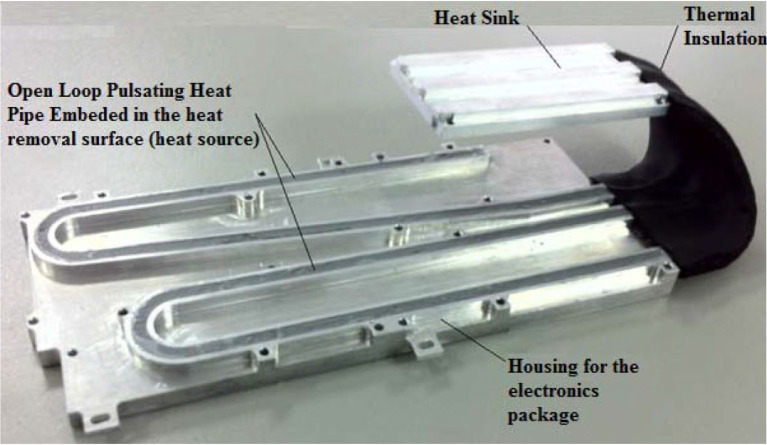
Pulsating heat pipe (Source: Riehl, 2016, doi: 10.4172/2168-9873.1000214) [CC BY].